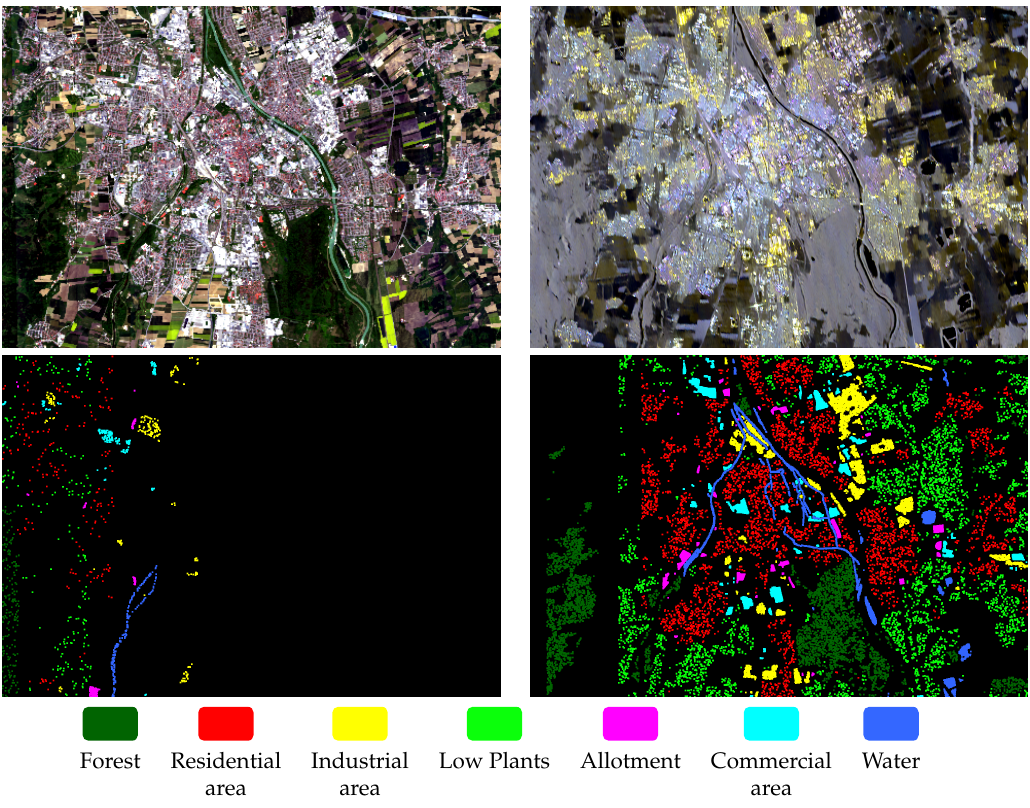
Figure 3. The Augsburg data set. From left to right, top to bottom: RGB components of the hyperspectral image; Sentinel-1 dual-Pol data; The training data; The testing